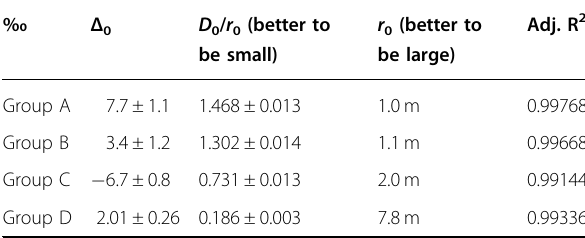
Table 5 Calculation datasheet of air fl ow